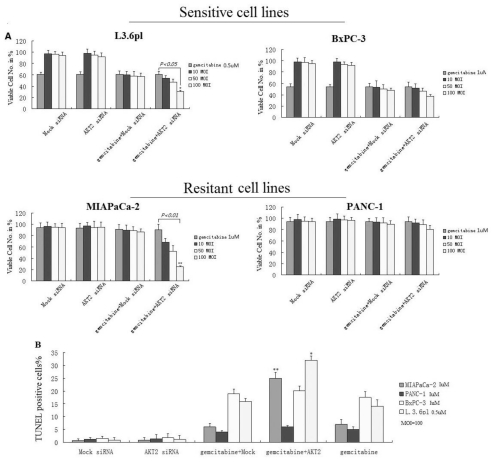
MTT and TUNEL assay showing cytotoxic effect of gemcitabine on AKT2 siRNA-transfected pancreatic cancer cell lines. (A) Cell viability assay was performed at 72 h after treatment with gemcitabine. AKT2 siRNA-transfected L3.6pl and MIA PaCa-2 cells showed significantly higher susceptibility to gemcitabine compared to gemcitabine alone (* P < 0.05, ** P < 0.01). AKT2 siRNA-transfected BxPC-3 and PANC-1 cells showed similar susceptibility to gemcitabine compared to gemcitabine alone (P > 0.05); (B) TUNEL analysis for measuring apoptosis induced by AKT2 inhibition, gemcitabine, and AKT2 inhibition combined with gemcitabine treatment. AKT2 siRNA transfection alone failed to induce apoptosis and inhibited proliferation in the four cell lines. In both assays, three separate experiments were performed and data from one representative experiment (mean ± SD of four replicates) are shown.